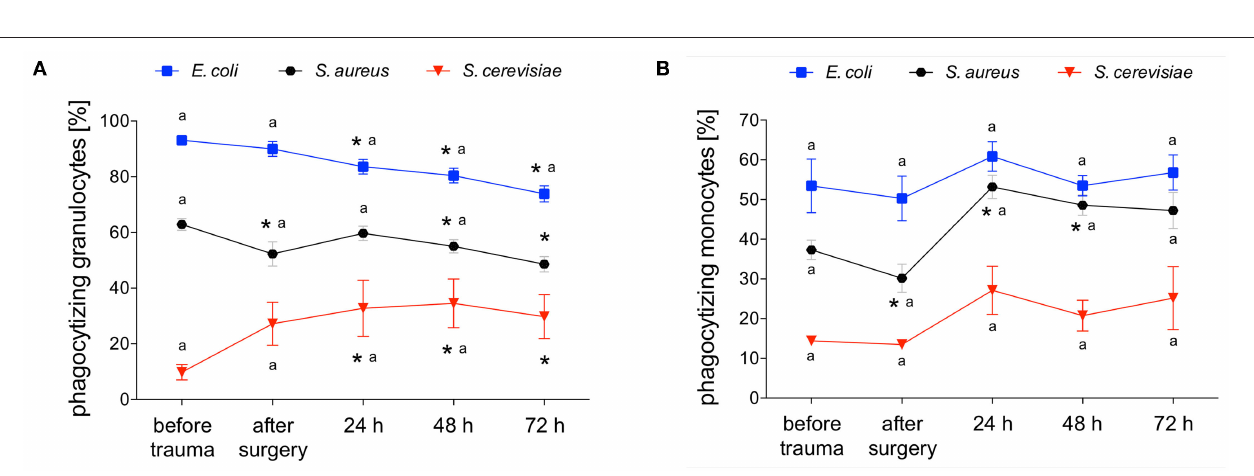
FIGURE 3 | Percentage of E. coli -, S. aureus - or S. cerevisiae -phagocytizing granulocytes and monocytes. The percentage of E. coli -, S. aureus - or S. cerevisiae -phagocytizing granulocytes (A) and monocytes (B) was measured with FACS-analysis before trauma, after trauma and after 24, 48 and 72h. Data are given as mean ± standard error of the mean, * p < 0.05 vs. baseline, n =